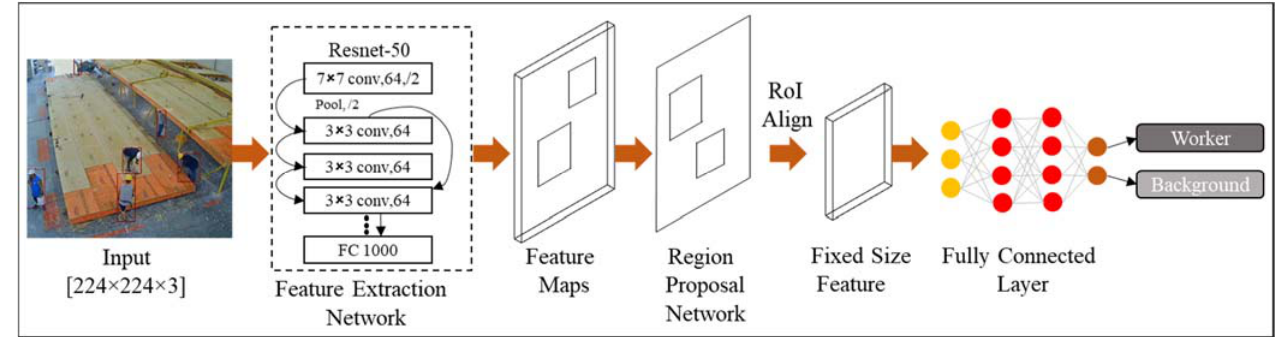
Figure 7. The architecture of the Mask R-CNN detection algorithm used in this